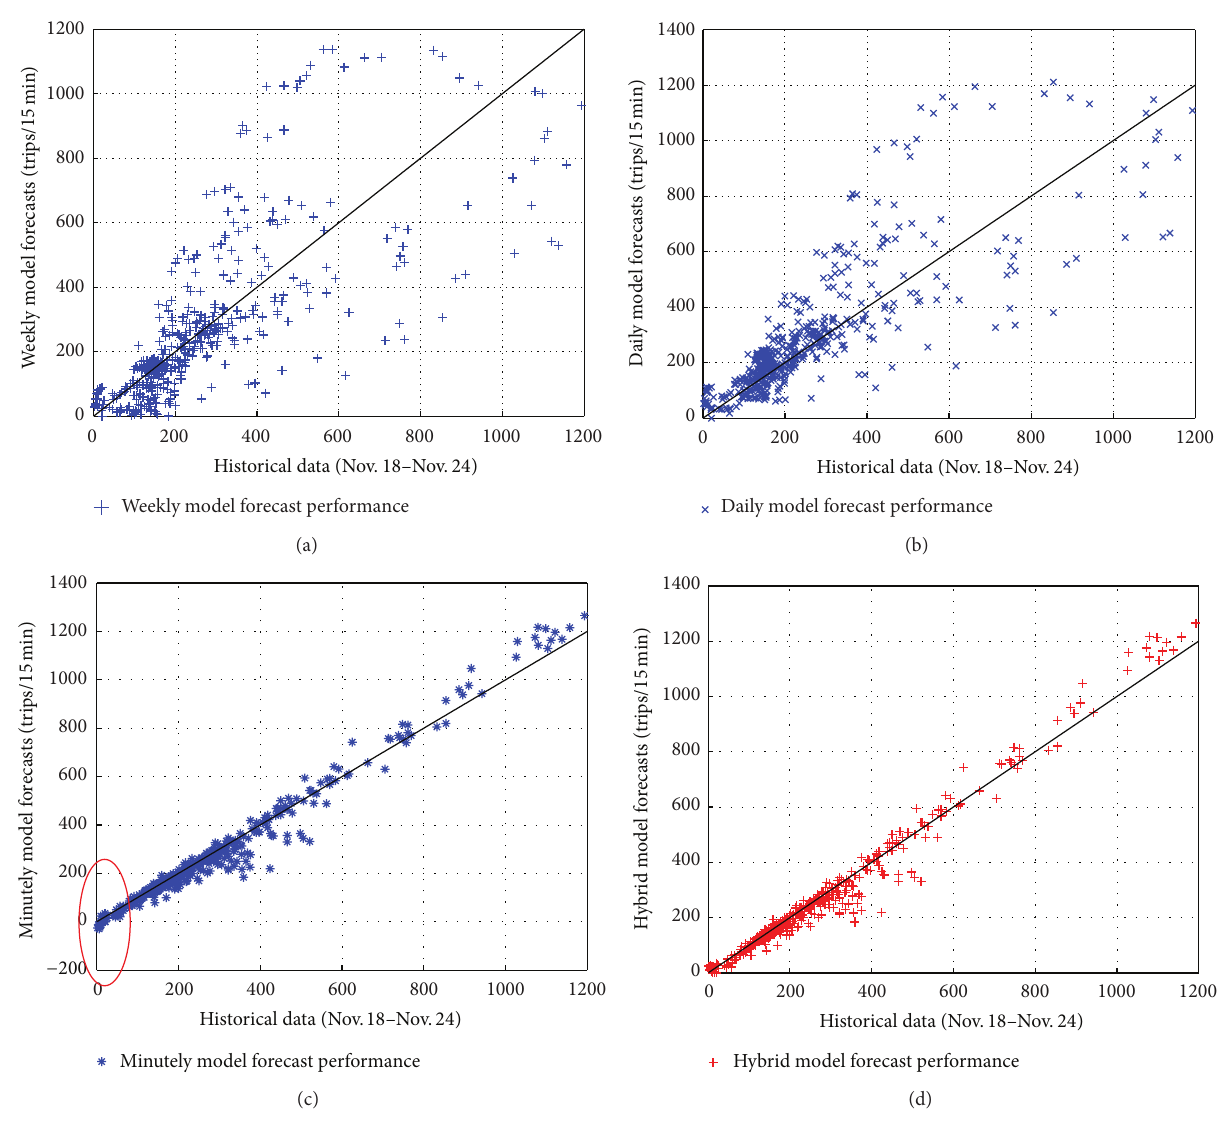
Figure 4: Comparison of forecasting performances of different models, (a) weekly model performance, (b) daily model performance, (c) 15min model performance, and (d) hybrid model